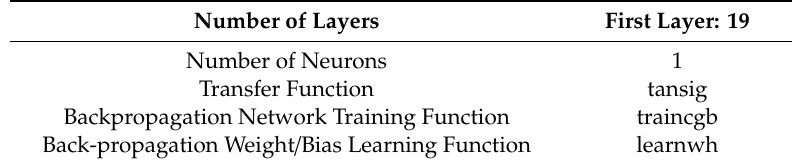
Table 1. The hidden layer structure of artificial neural network (ANN) used to select the most e ff ective wavelengths (tansig is transfer function; traincgb is training function; learnwh is learning